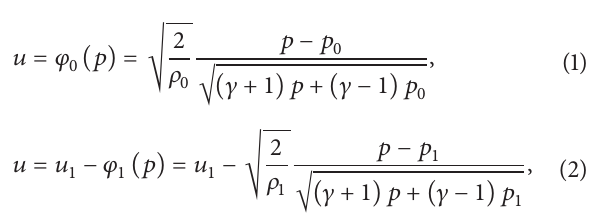
pressure-particle velocity curve of shock wave in reflection process on rigid